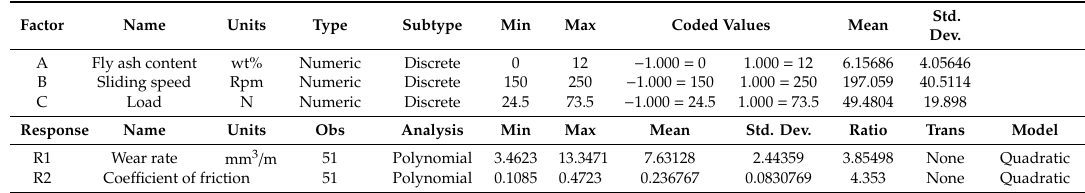
Table 4. Factorial design summary (Design-Expert